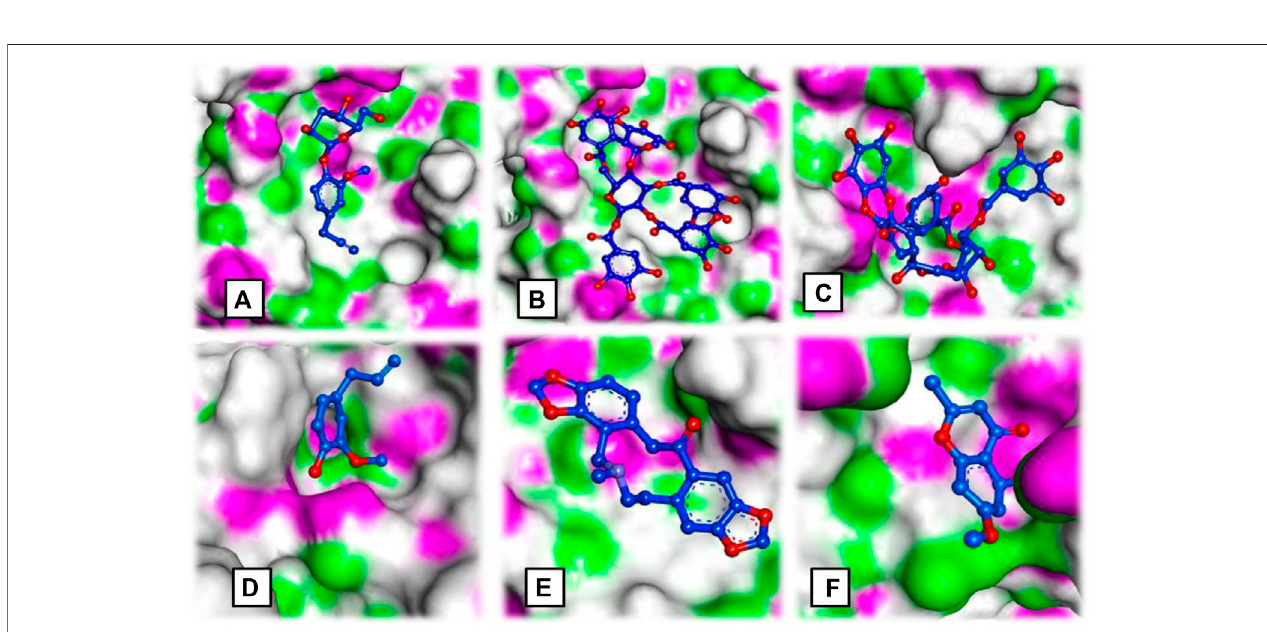
Frontiers in Molecular Biosciences |